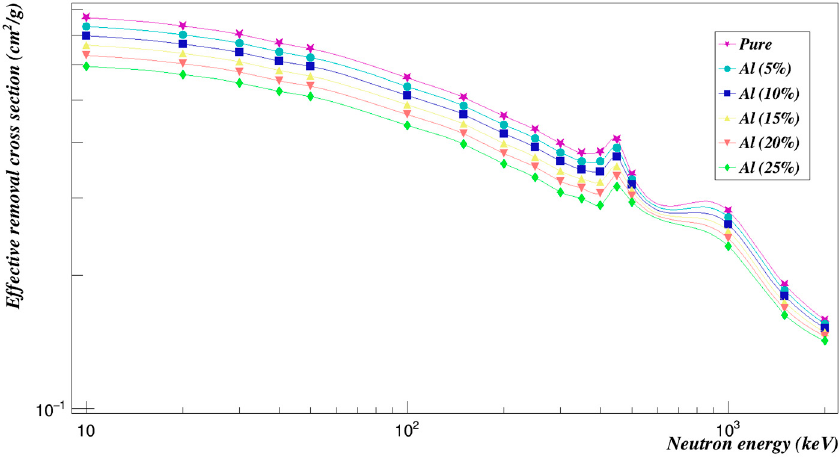
Figure 5. Neutron e ff ective removal cross sections of Polyimide doped with aluminum. Figure 5. Neutron effective removal cross sections of Polyimide doped with